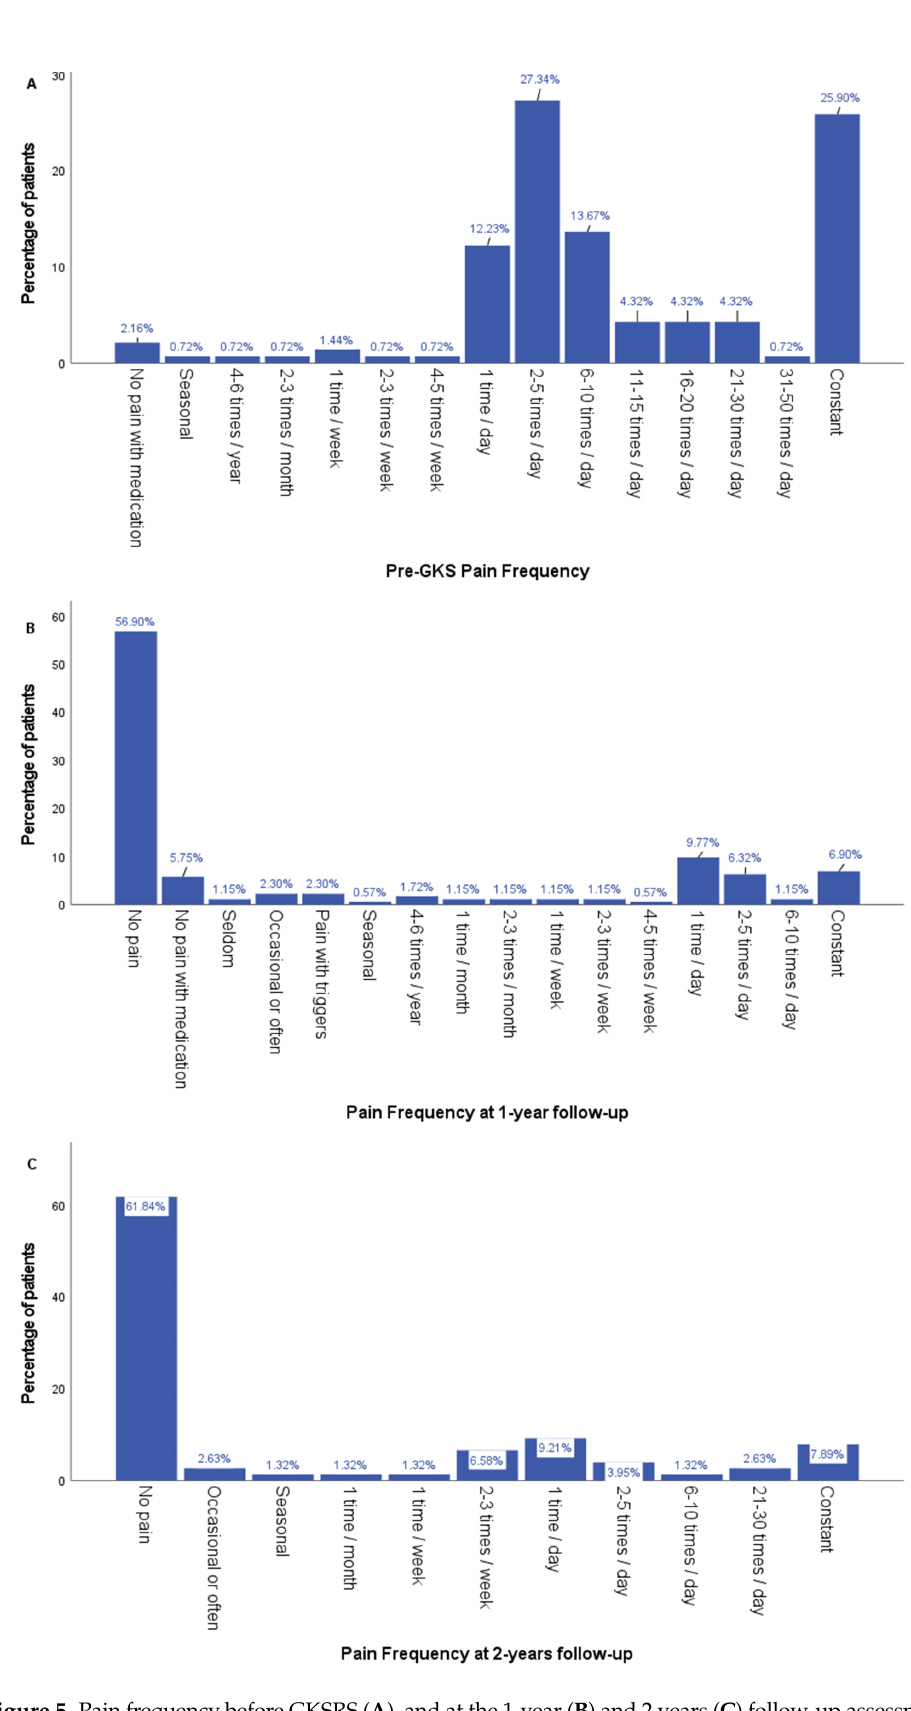
Figure 5. Pain frequency before GKSRS ( A ), and at the 1-year ( B ) and 2 years ( C ) follow-up assess- ments.